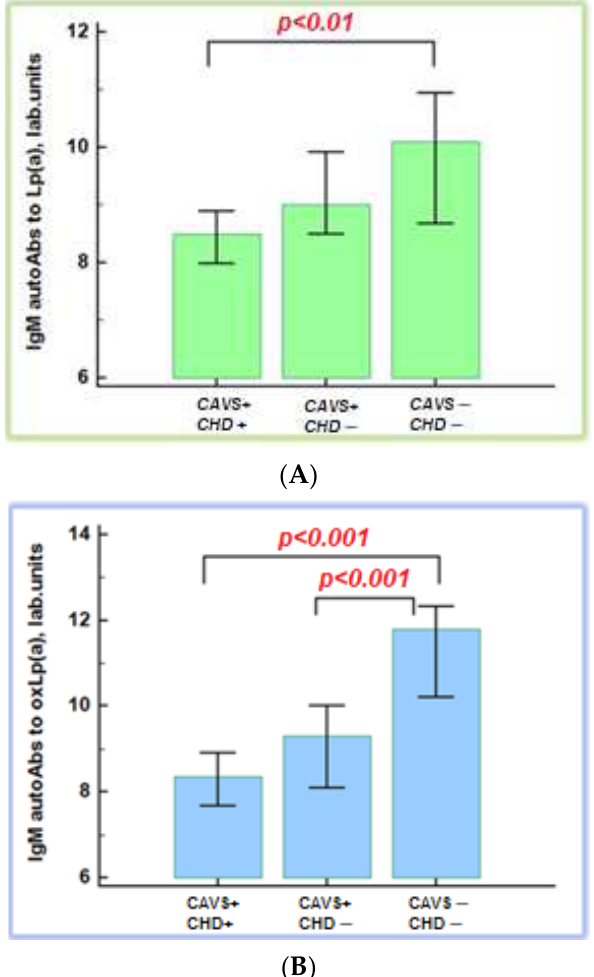
Figure 2. Immunoglobulin M autoantibodies to native ( A ) and oxidative lipoprotein(a) ( B ). CAVS—calcific aortic valve stenosis; CHD—coronary heart disease; autoAbs—autoantibodies; Lp(a)—lipoprotein(a); oxLp(a)—oxidized lipoprotein(a).